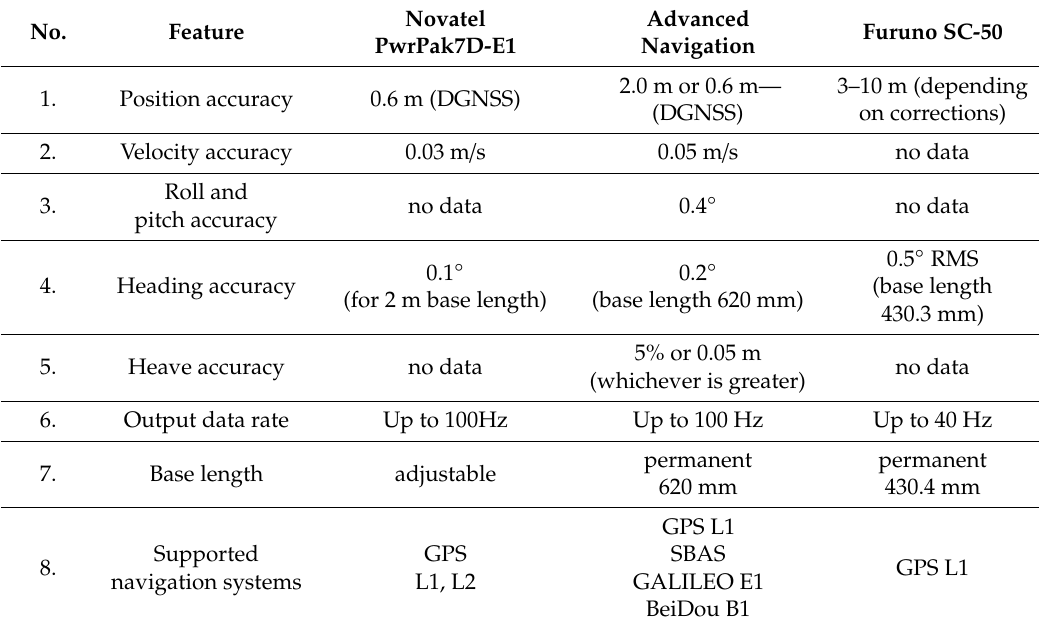
Table 1. Basic technical parameters of the three compared satellite compasses used in the experiments